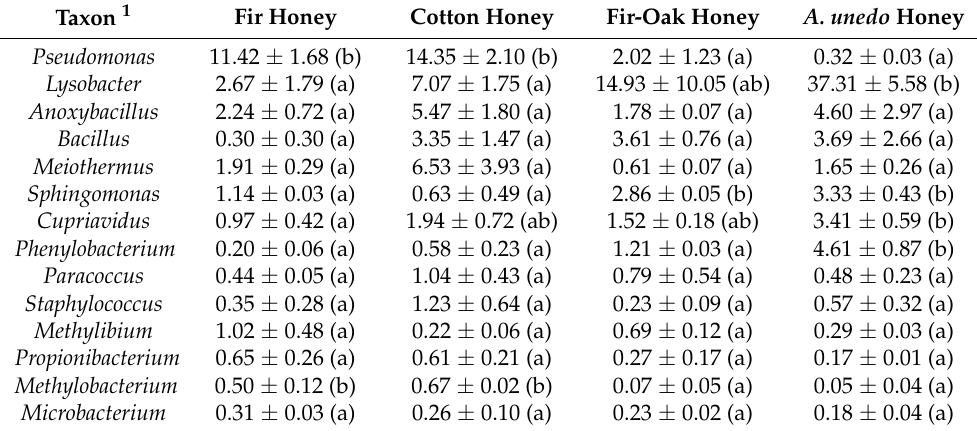
Table 2. List of bacterial taxa identified in all honey samples examined in order to serve as potential authenticity bioindicators of honey.